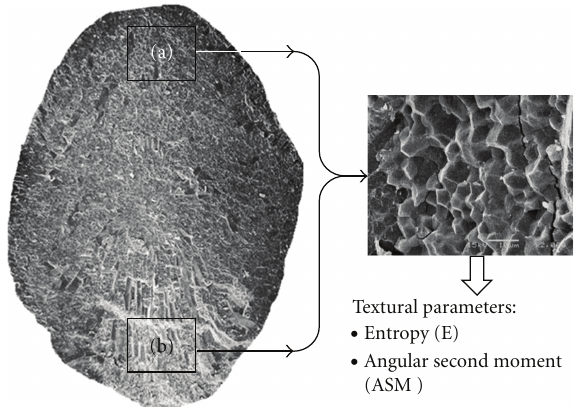
Figure 2: Micrograph SEM of grain transversal section of rice Morelos A-98 (500 X) showing regions (a) dorsal and (b) ventral, from which endosperm superficial texture parameters were ob-